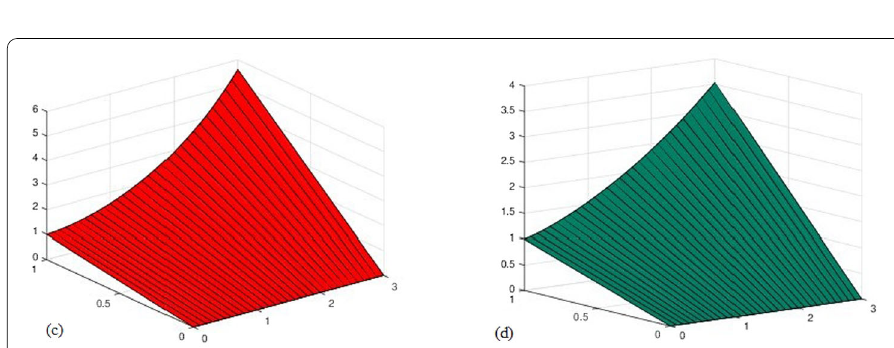
Figure 3 ( c ) Graphs of fractional-order results at γ = 0.8 and ( d ) γ = 0.6 of Example